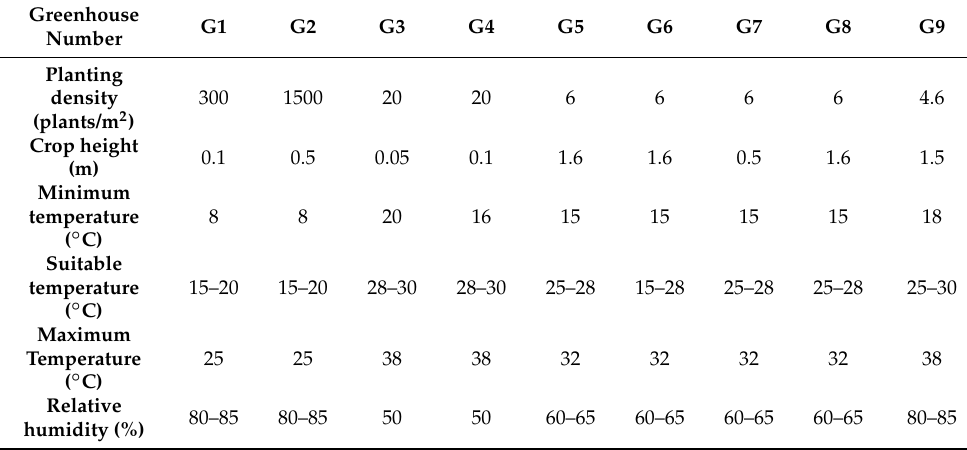
Table 2. Maintained temperature inside the greenhouse (local staff rules).